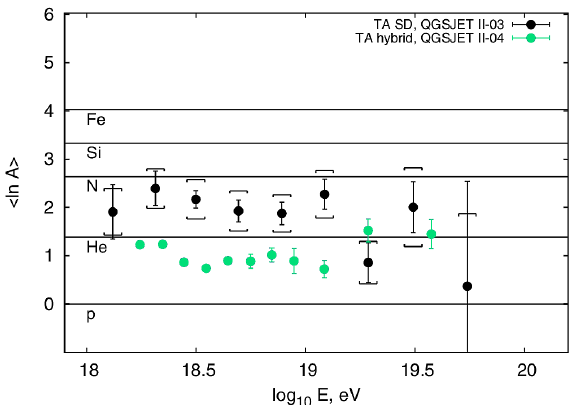
Figure 8: (cid:104) ln A (cid:105) observed by TA SD array using MVA analysis. (cid:104) ln A (cid:105) observed by BR / LR hybrid composition measurement is also shown. Both are in agreement with predominantly light